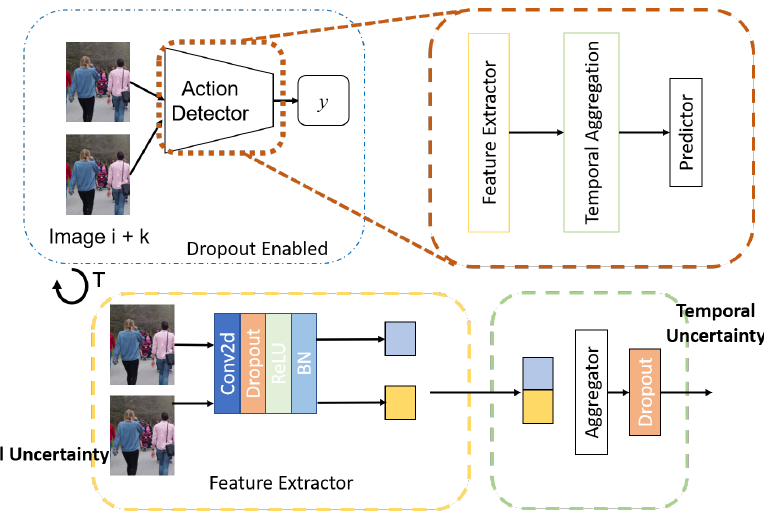
Figure 7. The spatial and temporal uncertainties are separated by changing the insertion points of the dropout layers. In the case of spatial uncertainty, the dropout layers are added in the CNN after every parameter layer. For temporal uncertainty, the dropout layers in the temporal aggregator